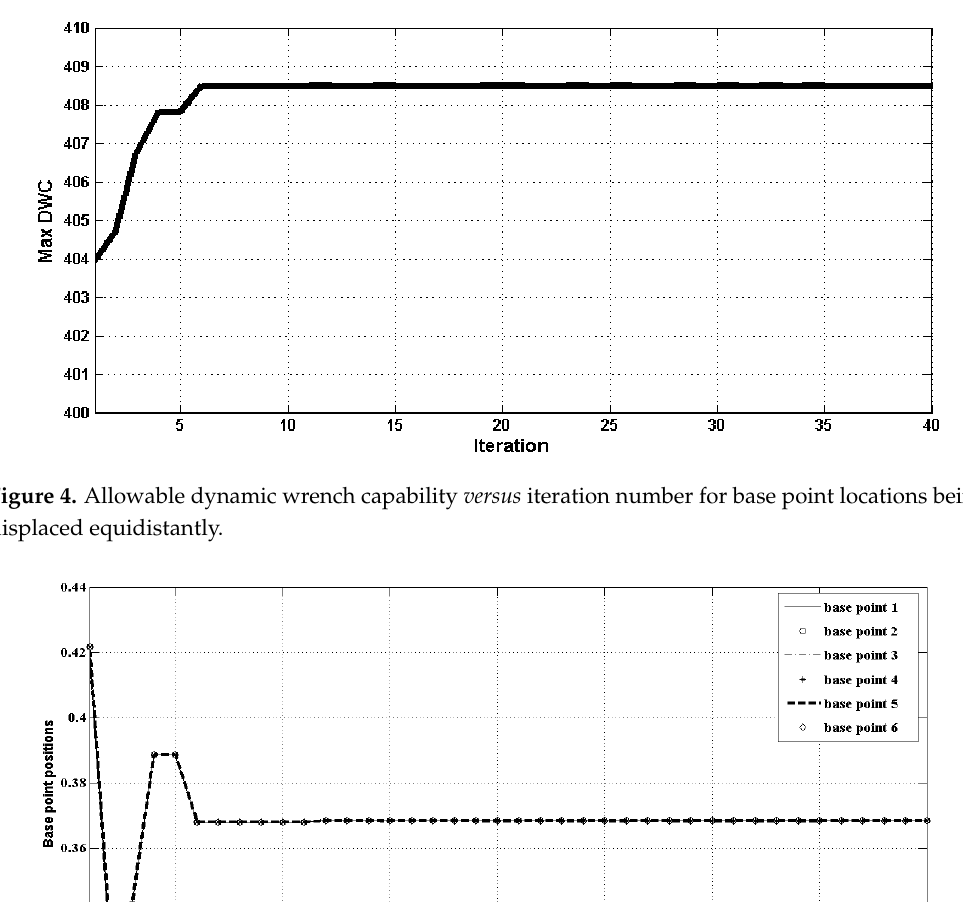
Figure 6. Variations of dynamic wrenches along prescribed trajectory for η i = 0.3684. Moreover, Table 1 lists the convergence analyses for different population size P = 15, 25, 35. As shown, the population size P = 35 goes through fewer iterations to reach the specified convergence criteria because of the wider and more random coverage of the search space; however, the